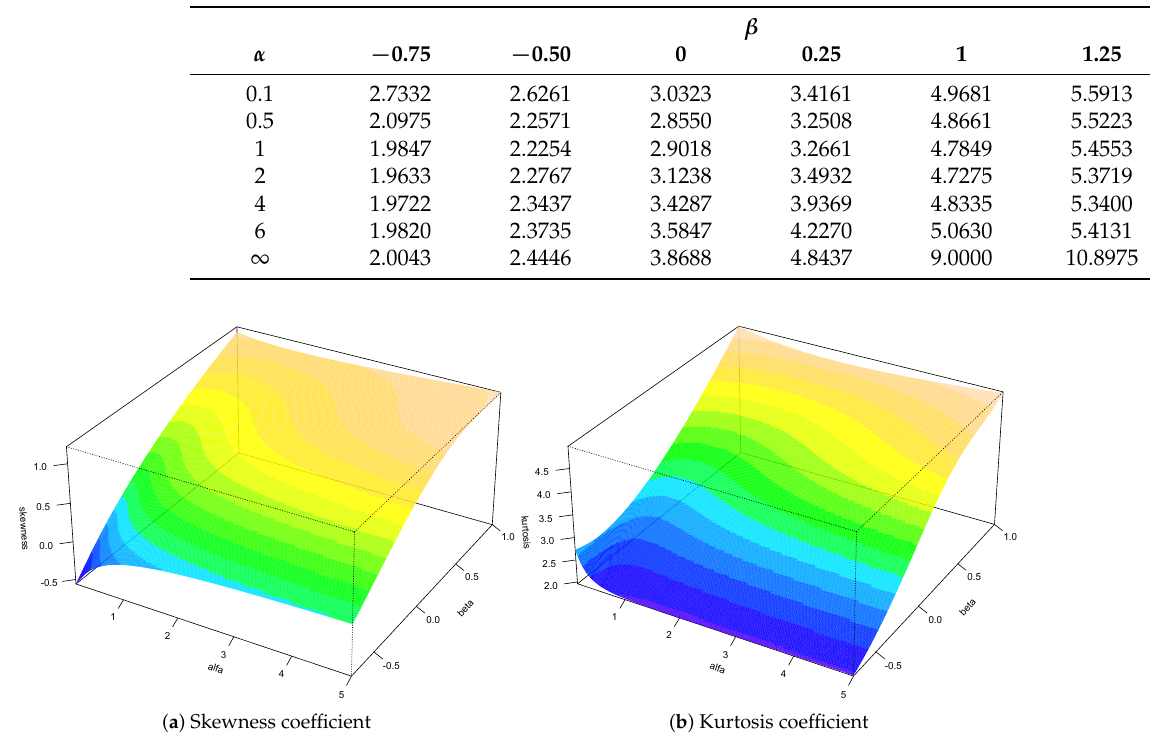
Table 2. Kurtosis coefficient in EHPE ( α ,1, β ) model for different values of α and β .